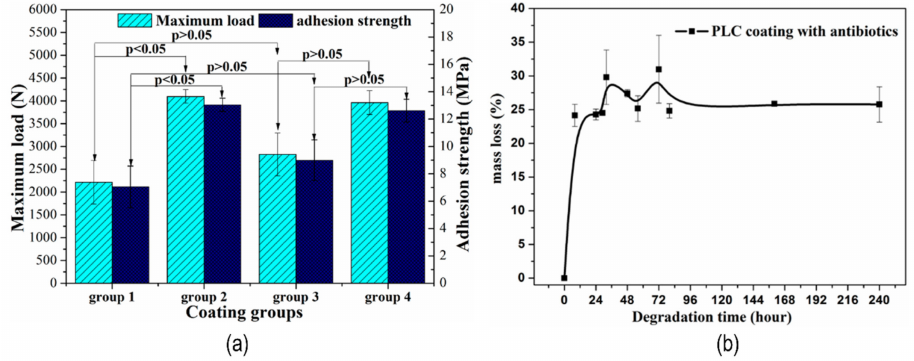
Figure 6. ( a ) Adhesion performance of various coating groups ( b ) degradation rate of coating of PLC coating. Adapted with permission from